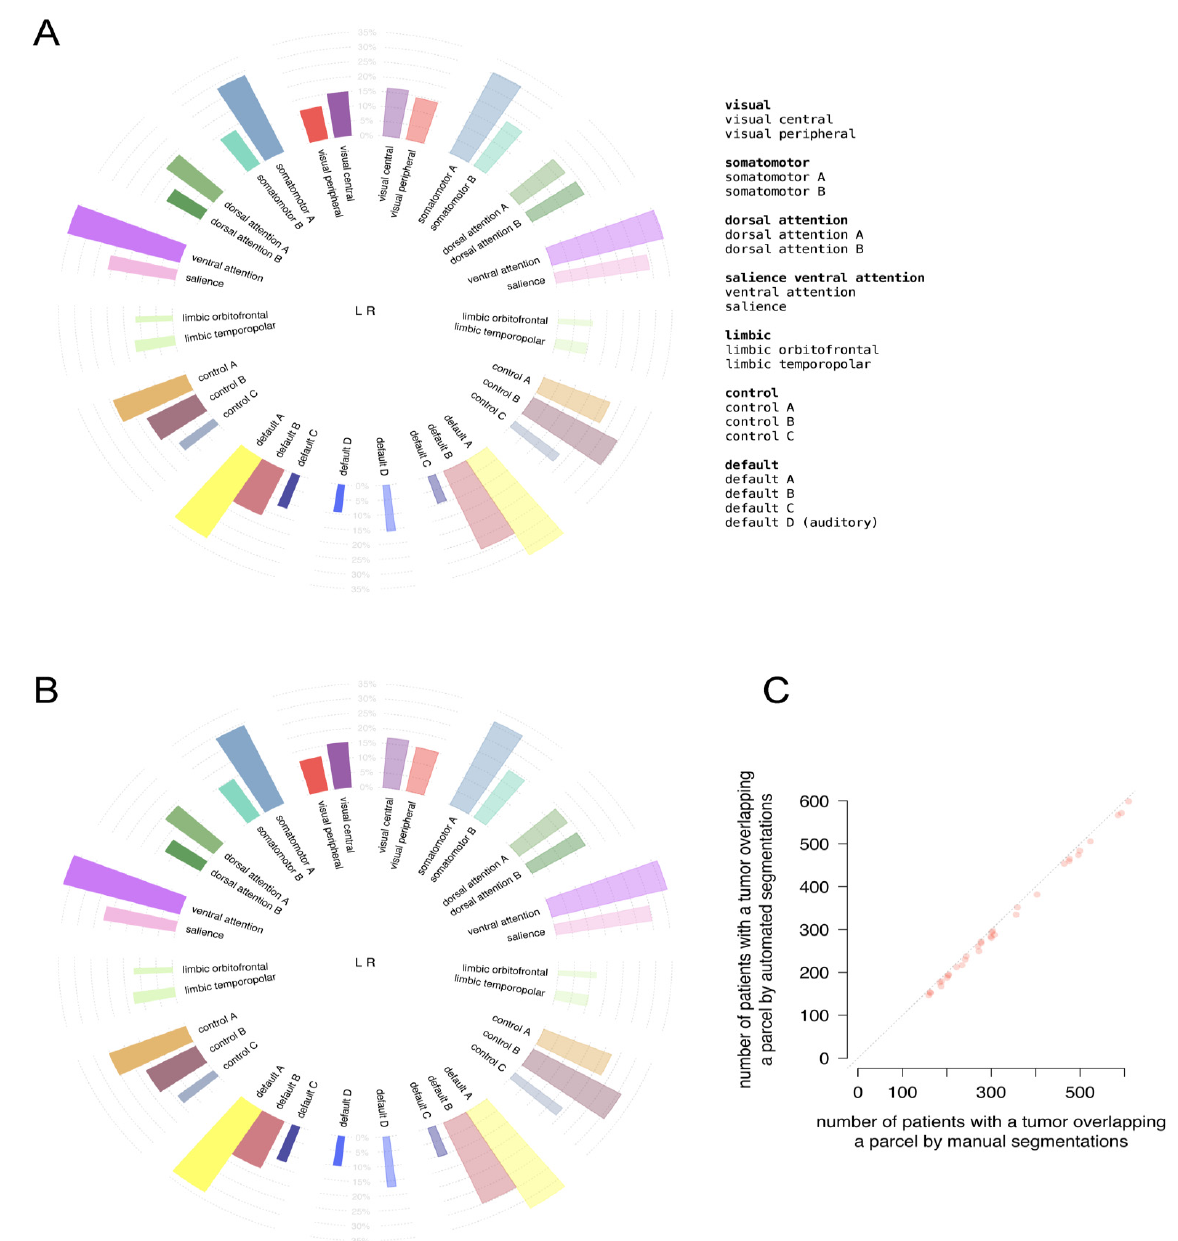
Figure 4. Comparison of tumor location profiles of cortical structures between ( A ) automated and ( B ) manual segmentations in Schaefer’s brain parcellation. In the circular bar plots, each bar represents one network class parcel. Abbreviations refer to classes as detailed in legend. The height of a bar represents the percentage of patients, indicated in grey, with tumor involvement in a class parcel. The width of a bar corresponds with the relative volume of a parcel. ( C ) Correlation plot between the number of patients with parcel involvement between the manual and automated segmentations. The dotted diagonal indicates the identity